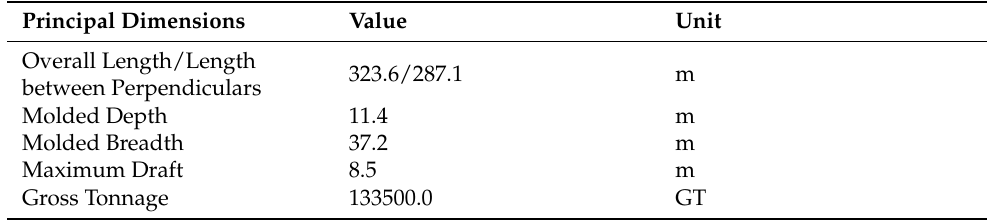
Table 5. The Vista cruise ship’s principal dimensions.